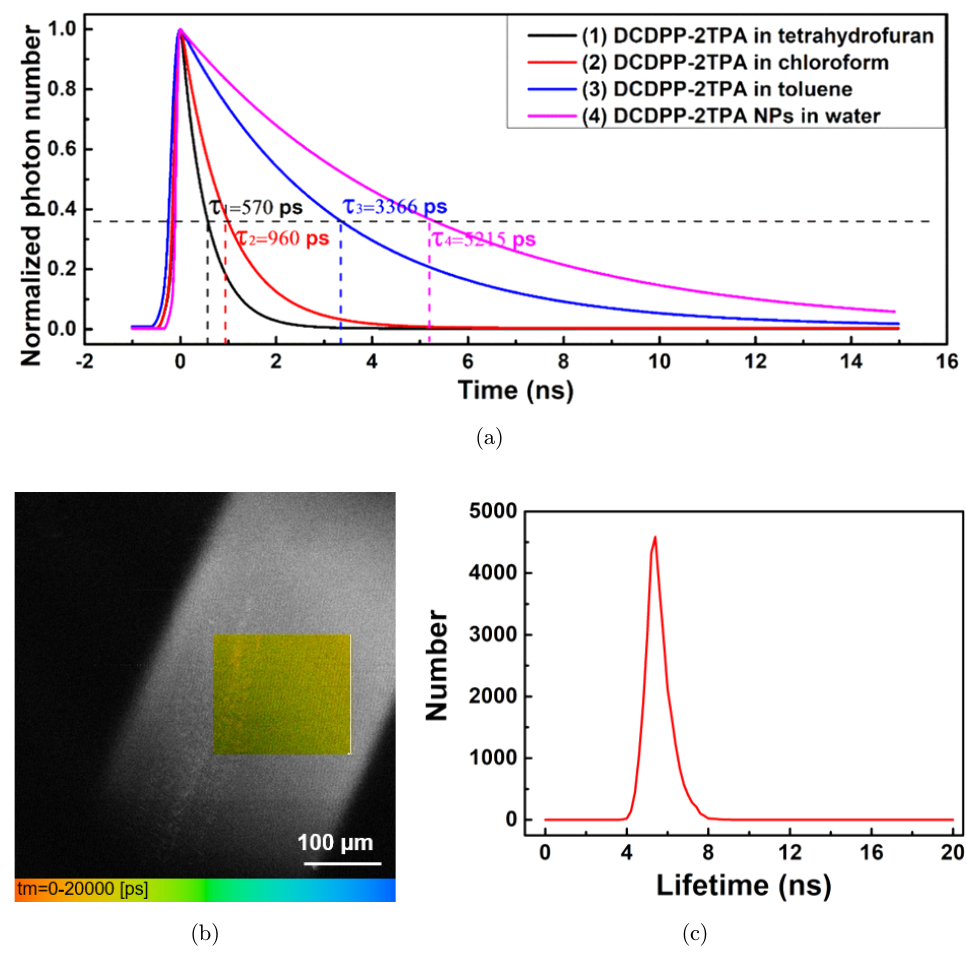
Fig. 2. (a) Time-resolved decay pro¯les of 3PF of DCDPP-2TPA in tetrahydrofuran (black line), chloroform (red line), toluene (blue line), and DCDPP-2TPA nanoparticles in water (pink line). The lifetimes of each solution were measured to be 570, 960, 3366 and 5215 ps. (b) Three-photon °uorescence intensity image (in grayscale) and three-photon °uorescence lifetime image (quadrate color map) of DCDPP-2TPA nanoparticles in water contained in a glass capillary tube. (Scale bar: 100 (cid:1) m) (c) Distribution of lifetime within the region of color map in